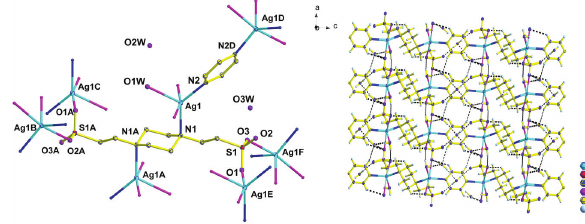
Table 1: Data collection and handling.